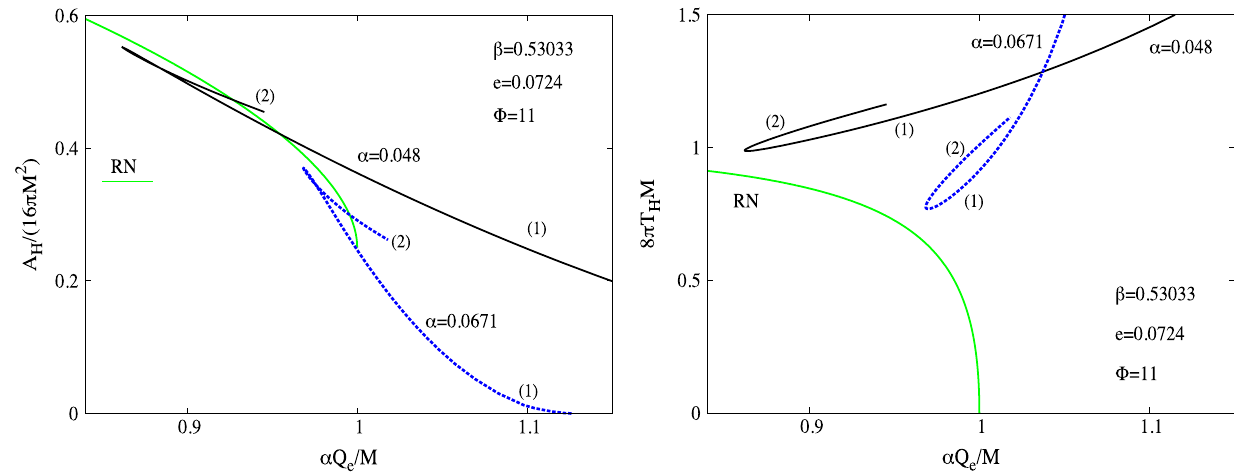
Fig. 5 Reduced area (left panel) and temperature (right panel) of both Q -hairy BHs and the RN BH in terms of their charge to mass ratio for fixed (β, e ,(cid:17)) and three sample values of α . The Q -hairy BHs can become entropically favoured sufficiently close to extremality and there is always a gap with the RN